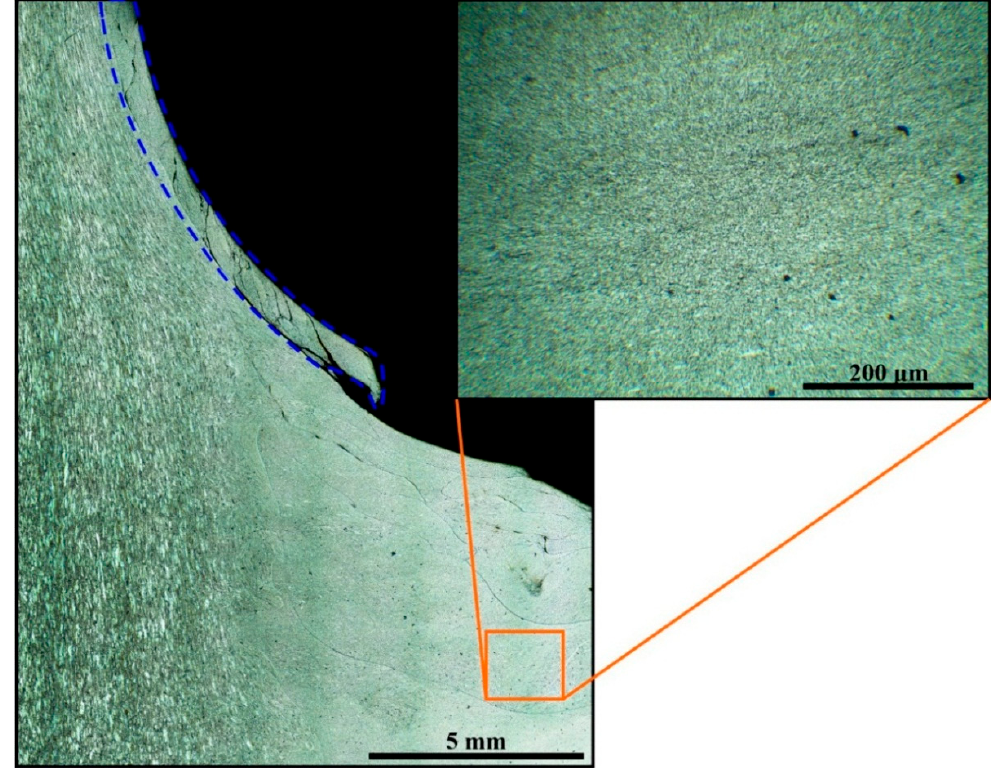
Figure 14. Optical images of the microstructures formed in the FSW tool exit hole metal trailing edge metal (Section 3.2 in Figure 2). The blue dotted line contour denotes the transfer layer area.